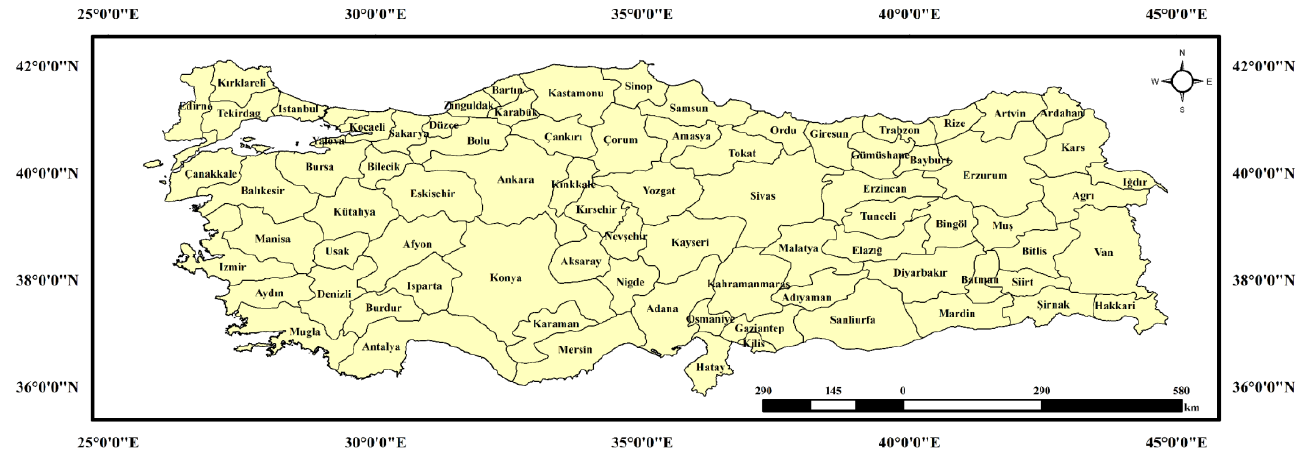
Figure 1. Flowchart of the simulation model.